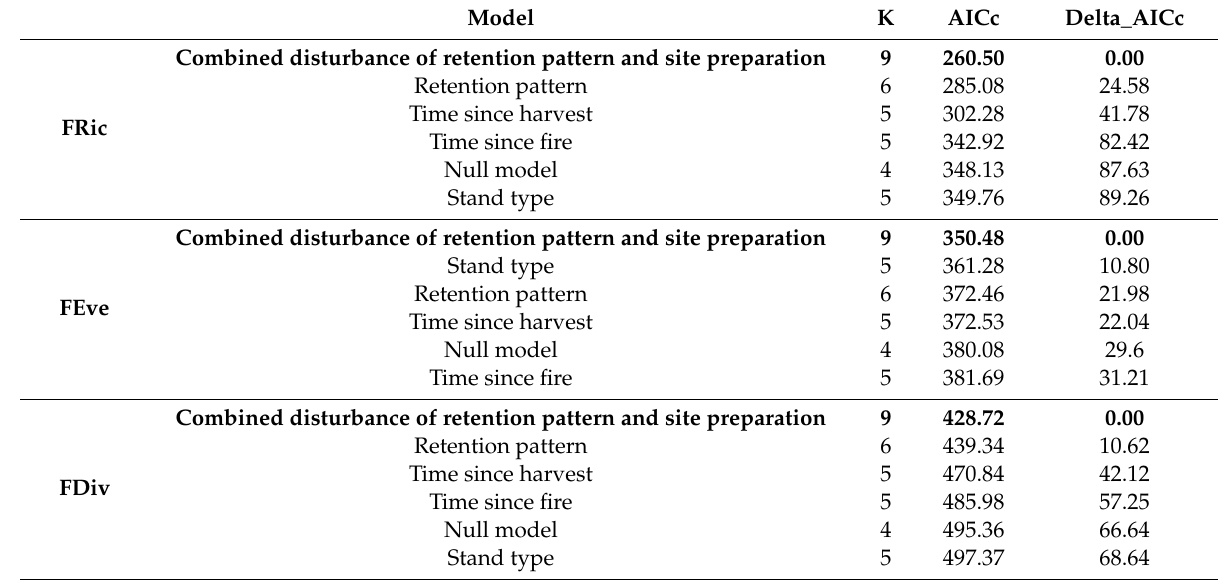
Table 4. Model selection results for the three functional diversity